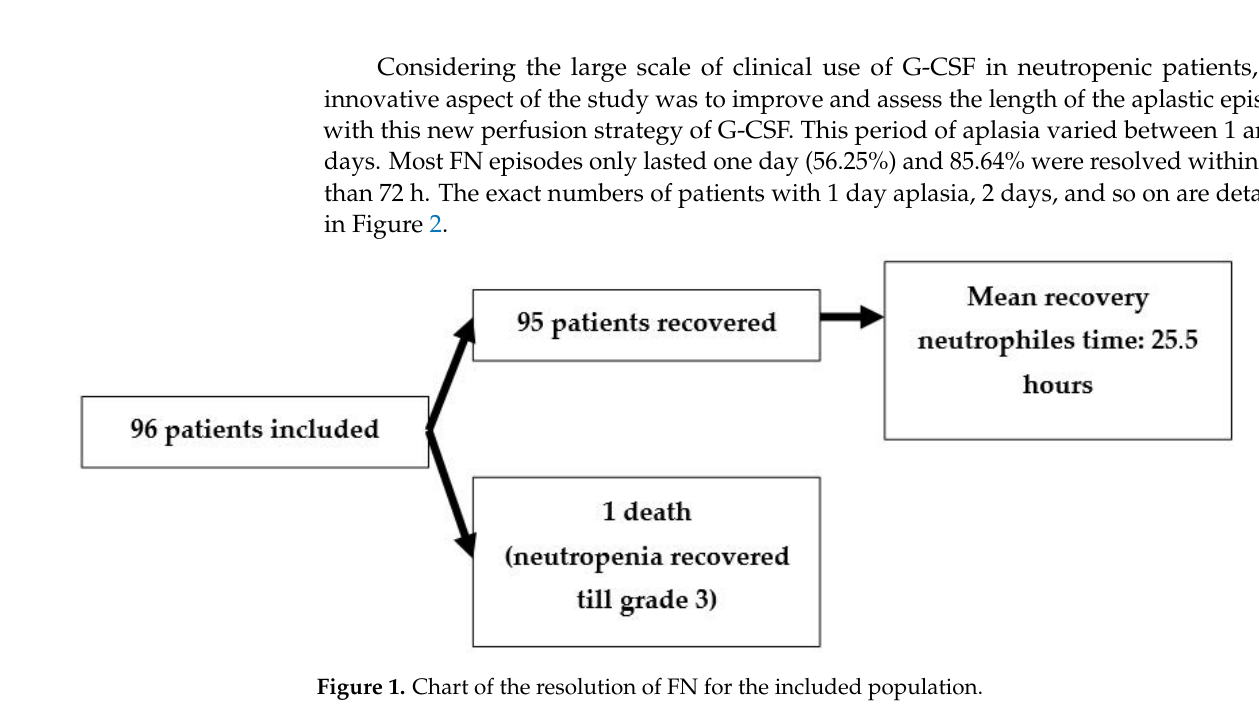
Figure 1. Chart of the resolution of FN for the included population.